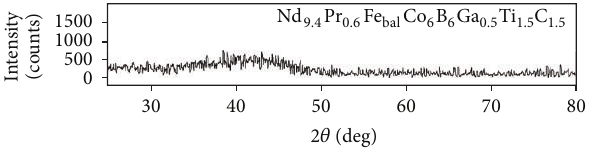
Figure 2: X-ray diffraction patterns of as-spun ribbon.